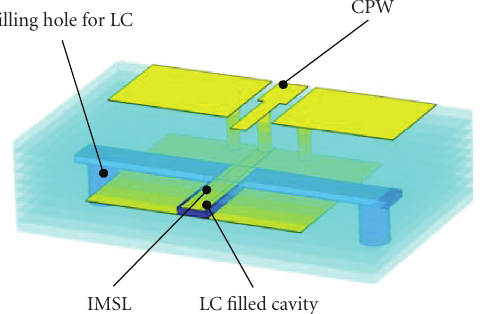
Figure 6: LTCC structure of the CPW to IMSL transition.